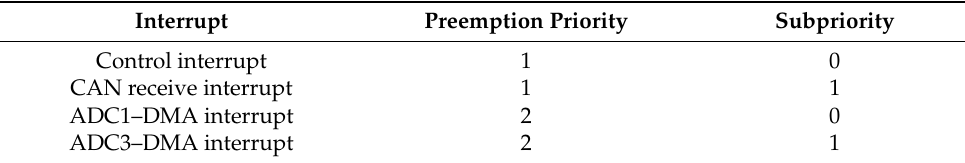
Figure 7. The flow chart of ISR. Table 1. Configuration of interrupt